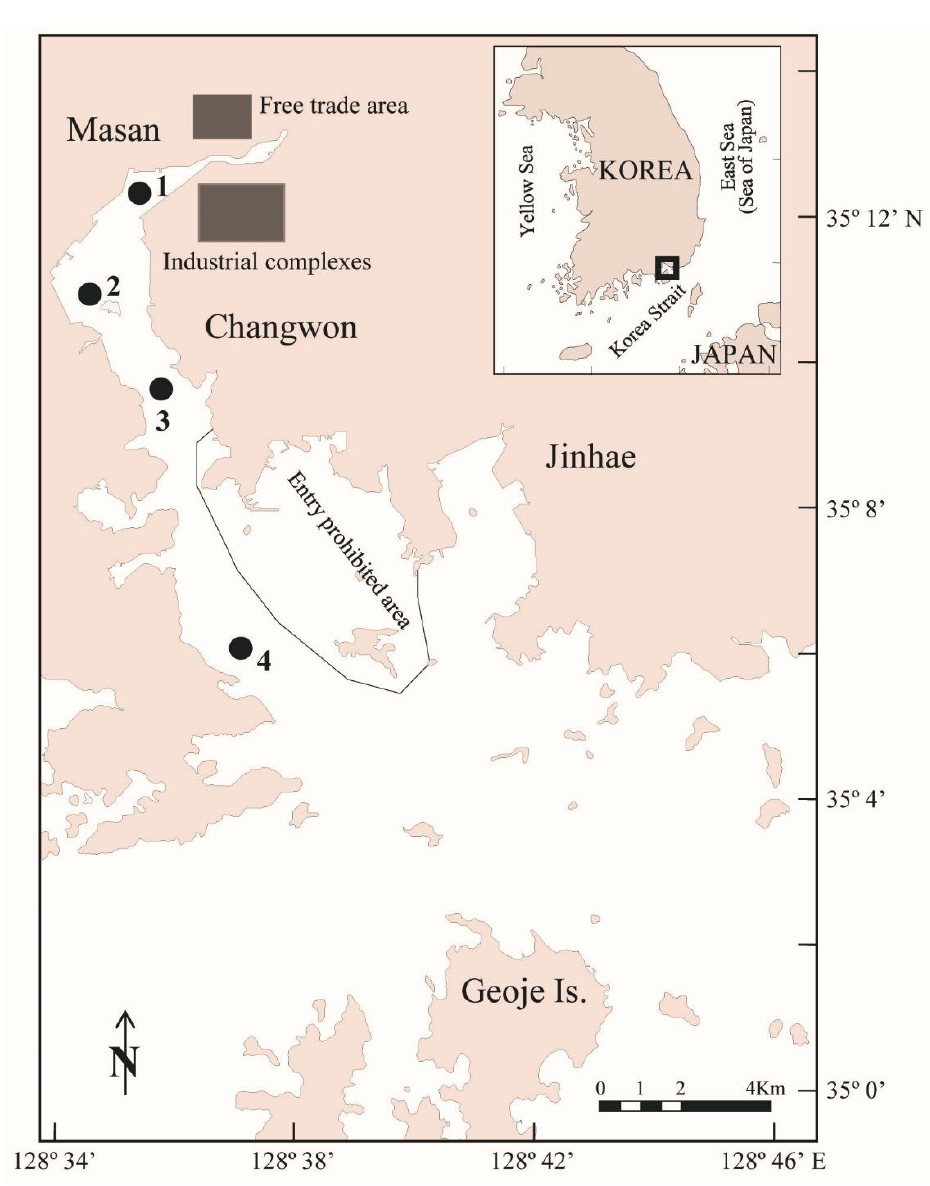
Figure 1. Sampling stations in Masan Bay, Korea.